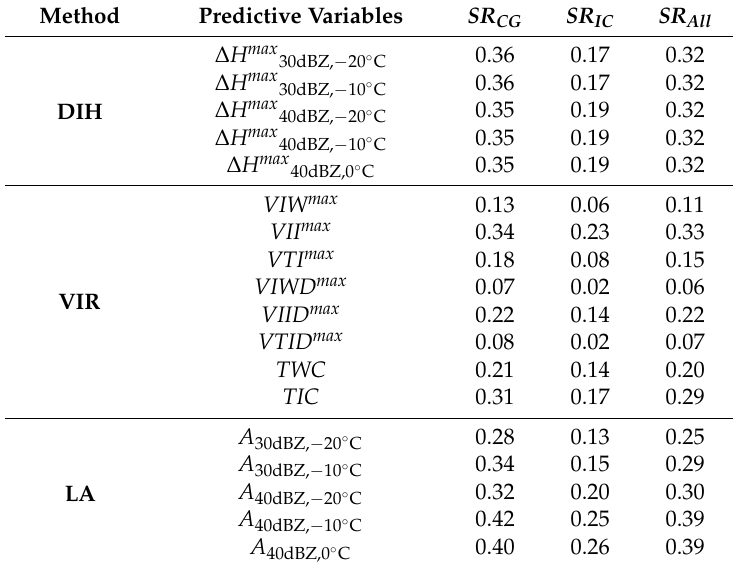
Table 4. Pearson correlation coefficient between the investigated radar-based detection variables and the stroke rate ( SR ) measured by LINET within the radar coverage in ∆ t = 2 min. Results are partitioned in terms of CG, IC, and all types of